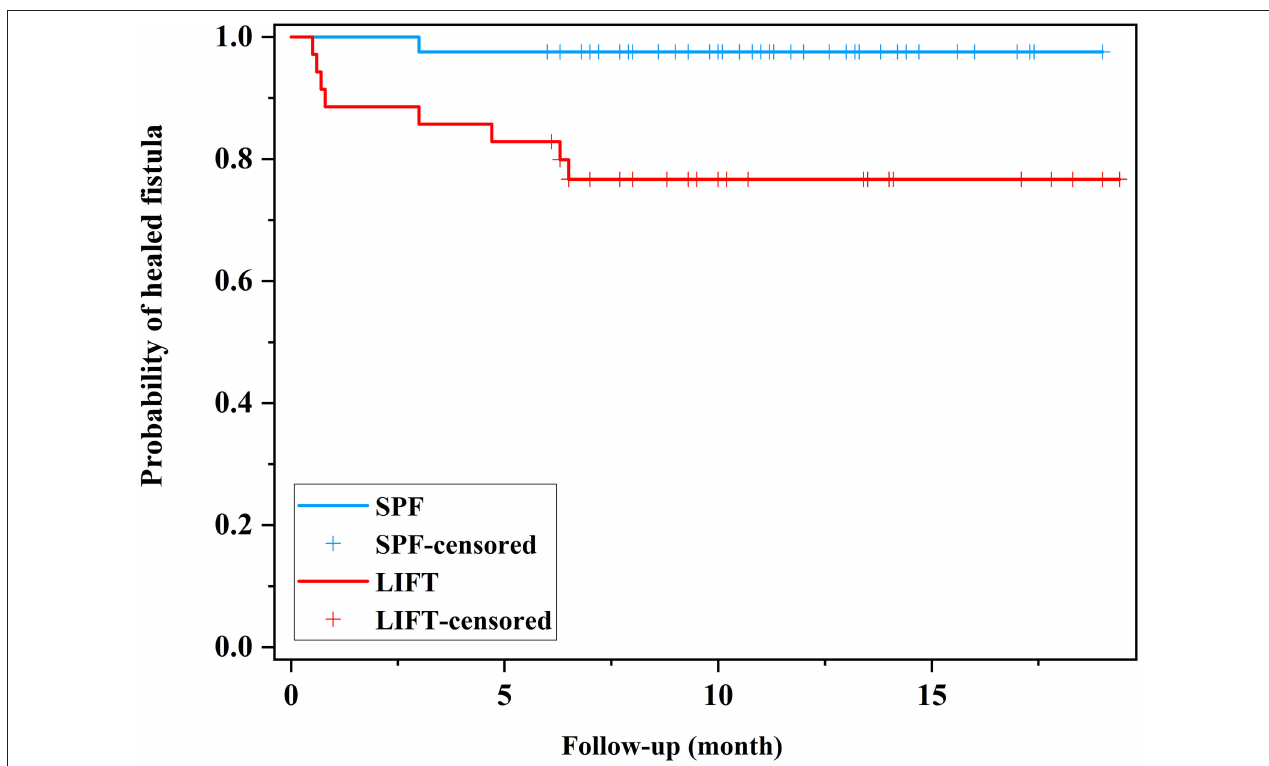
FIGURE 2 | Kaplan–Meier curve showing the recurrence rate during the follow-up period. SPF, sphincter-preserving fistulectomy; LIFT, ligation of the intersphincteric fistula tract.